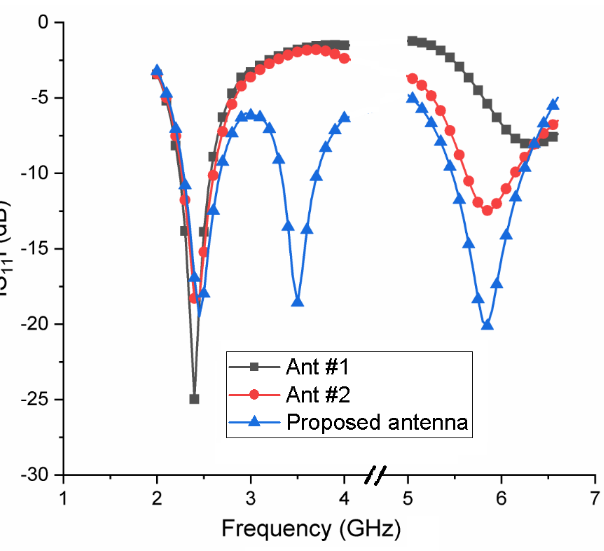
Figure 2. Simulated reflection coefficients of two prototype antennas and the proposed antenna.